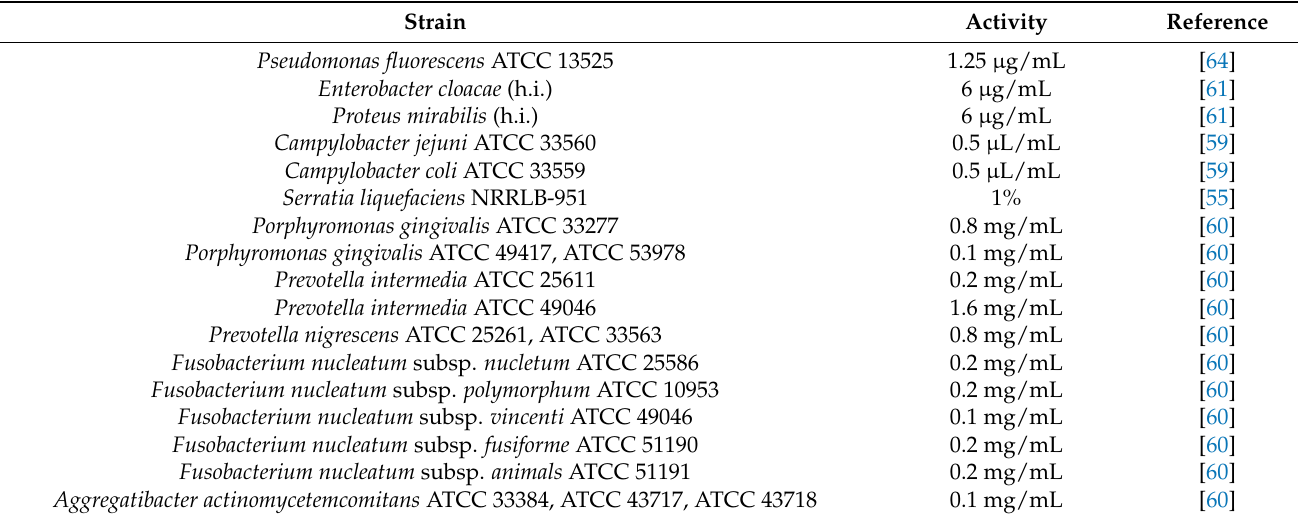
Table 2. Cont. Strain Activity